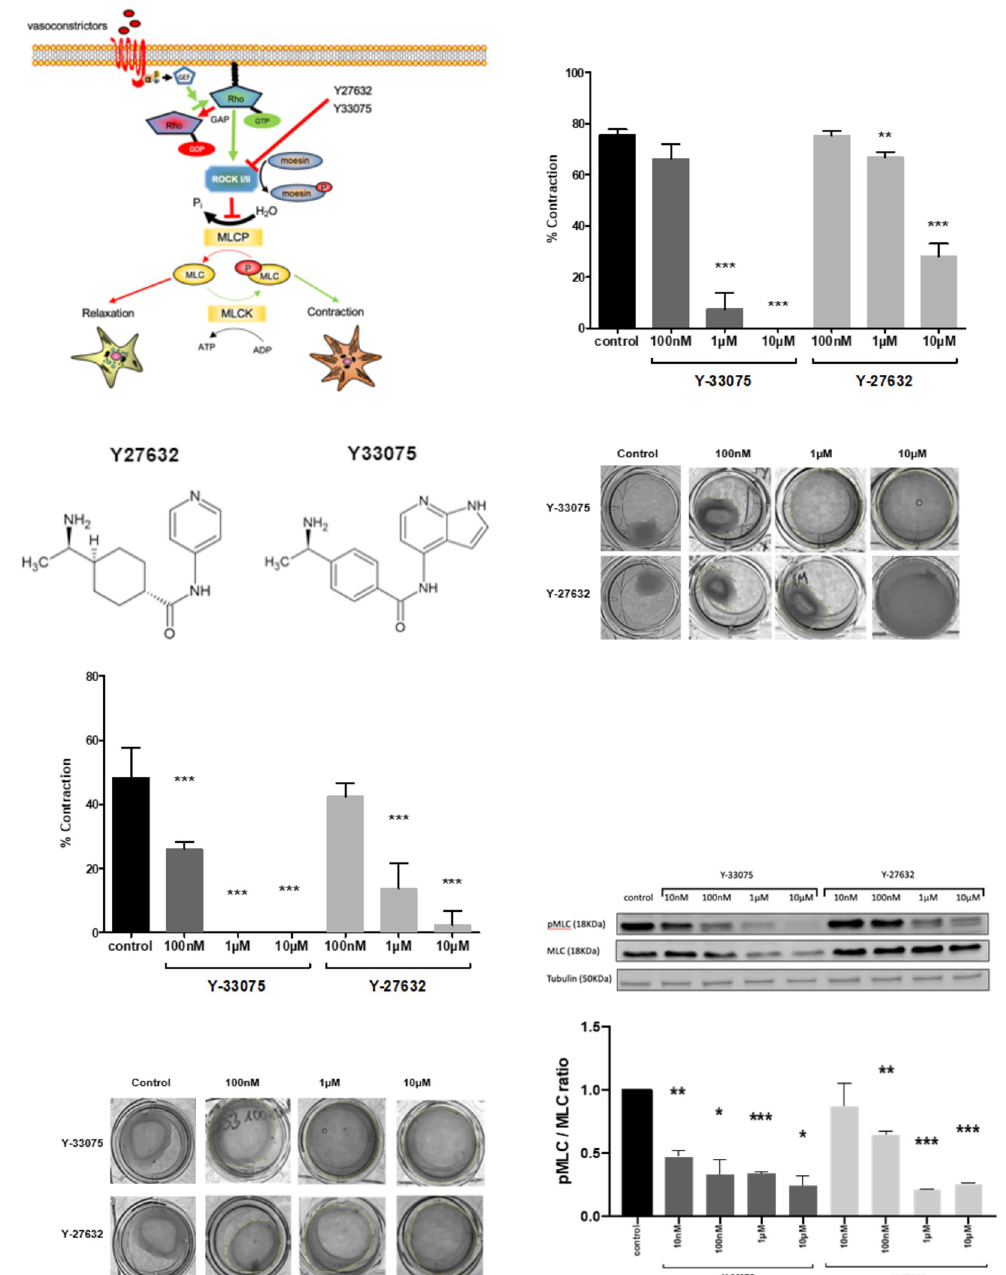
Fig 1. Y-27632 and Y-33075 treatments reduce contraction in human TWNT-4 and primary murine HSCs. (A) Schematic depiction of the RhoA-ROCK pathway including mechanism of action of the ROCK inhibitors Y-27632 and Y- 33075. (B) Chemical structure of ROCK inhibitors Y-27632 and Y33075. (C) Effect of Y-27632 and Y-33075 on collagen gel contraction of activated human TWNT-4 cells (n = 3). (D) Representative images of the contraction assay in TWNT-4 cells after incubation with the ROCK inhibitors for 24 hours. (E) Effect of Y-27632 and Y-33075 on collagen gel contraction of culture-activated primary murine FVB/NJ cells (n = 3). (F) Representative images of gel contraction in FVB/NJ cells 24 hours after treatment with the ROCK inhibitors. (G) Protein expression levels of phospho-MLC and MLC in TWNT-4 after 24 hour incubation with the ROCK inhibitors. (H) Ratio of phospho-MLC to MLC in TWNT-4 cell lysates after treatment with ROCK inhibitors for 24 hours (n = 2). Results are expressed as the mean ± standard error of the mean (SEM); � p < 0.05, �� p < 0.01 and ��� p < 0.001.